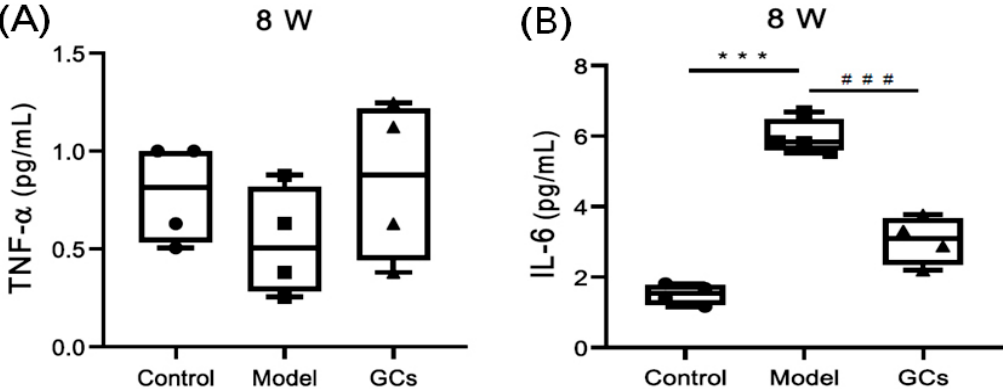
Figure 2. Comparison of concentrations of cytokines in serum samples from MRL/lpr mice of different groups. Serum samples of the control ( n = 4), model ( n = 4), and GCs ( n = 4) groups were collected at eight weeks of age (pre-LN state). The concentrations of cytokines TNF- α (Panal A ) and IL-6 (Panal B ) in serum samples of mice from different groups were determined with corresponding ELISA kits, respectively. The filled circle, square and triangle represent the control, model, and GCs group, respectively. The data present means ± SEM (standard error of the mean) from different groups. *** p < 0.001 compared with those in the control group, ### p < 0.001 compared with those in the model group.